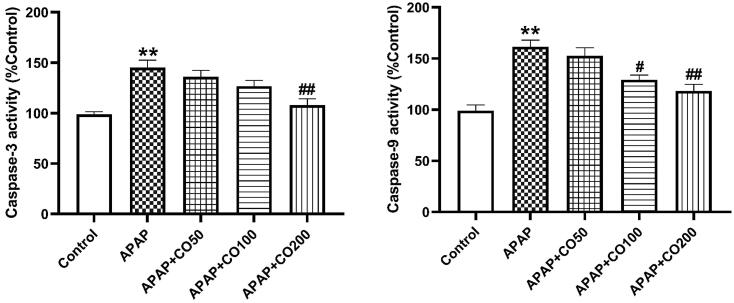
CO attenuated activation of caspase-3 (5) and caspase-9 (6) in kidney tissue of rats treated with APAP. Data presented as Mean ± SEM (n = 6). **p < 0.01 designates significant difference between only APAP from control group, #p < 0.05 and ##p < 0.01 shows significant difference from APAP untreated group (VEH).